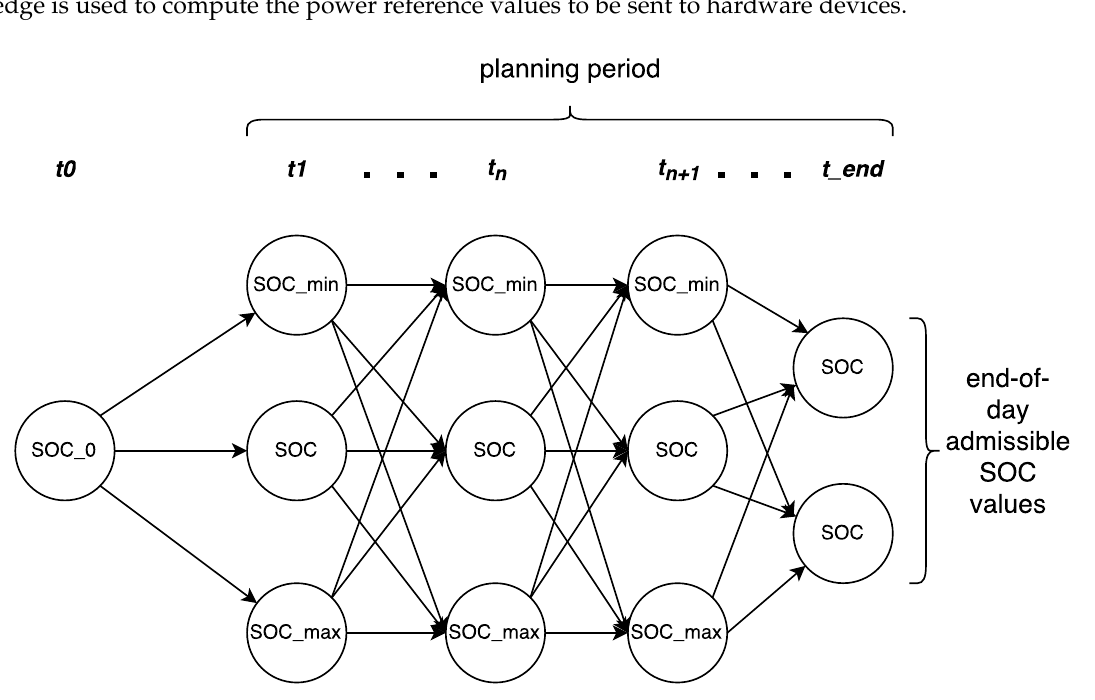
Figure 3. Graph of SOC values representing the actions and the resulting states that the system can choose to schedule its